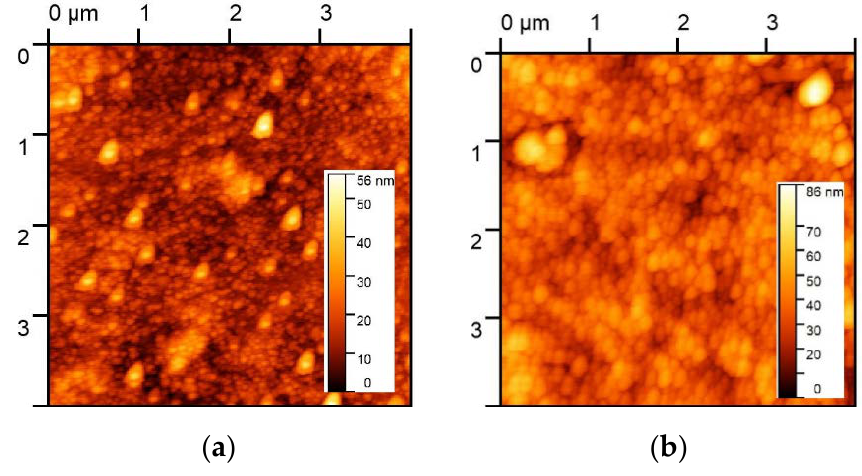
Figure 1. Surface morphology of ( a ) GO1 and ( b ) GO4. GO flakes densely cover the entire surface. Therefore, the difference in electrical characteristics discussed in the text was attributed to the oxidation degree and not to the coverage condition.